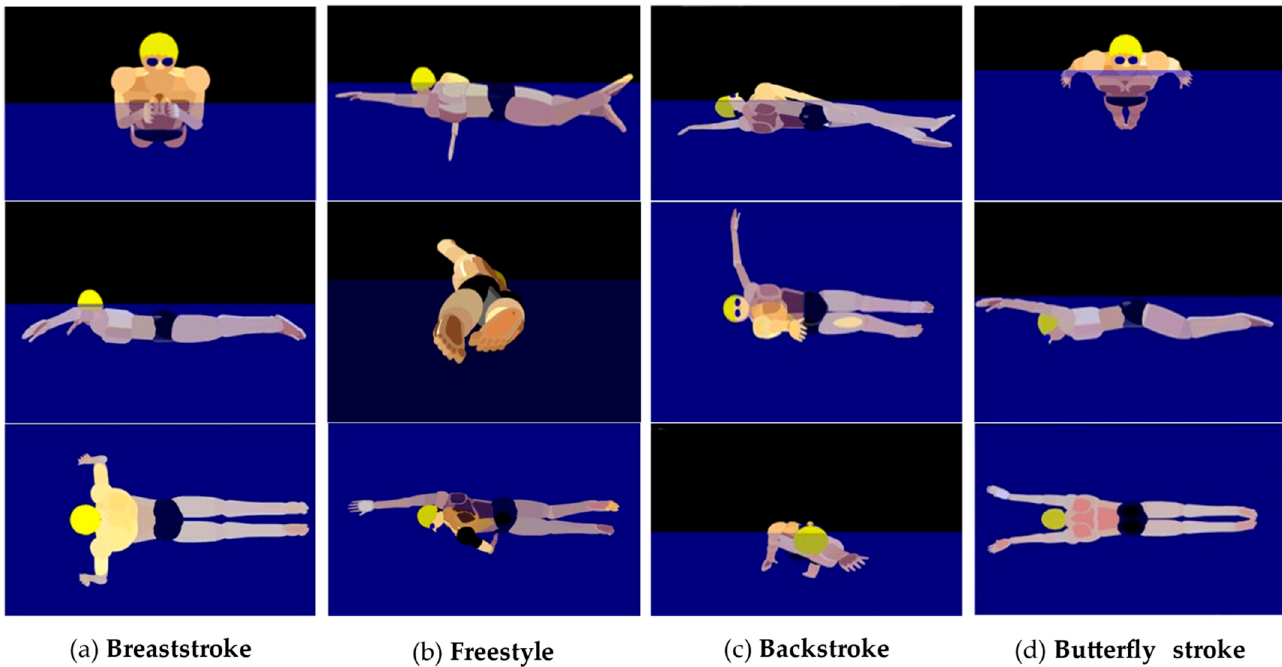
Figure 1. Front view, side view and top view of the four strokes. ( a ) Breaststroke action view. ( b ) Freestyle stroke attempts. ( c ) Backstroke action view. ( d ) Butterfly action view.